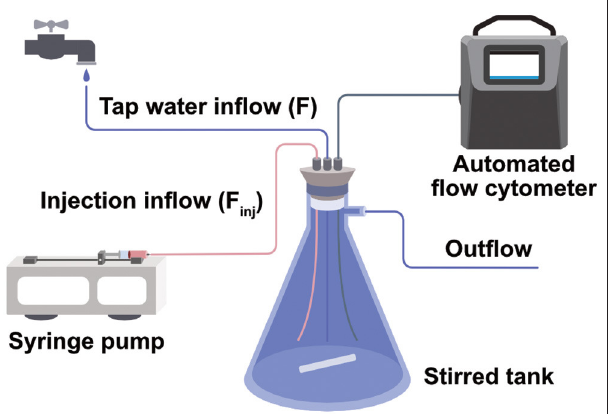
FIGURE 4 | Set-up of a water tank simulating a continuously operating water system. Tap water flows through a 1L stirred flask connected to an automated flow cytometer. Intermittently wastewater is injected to induce microbial